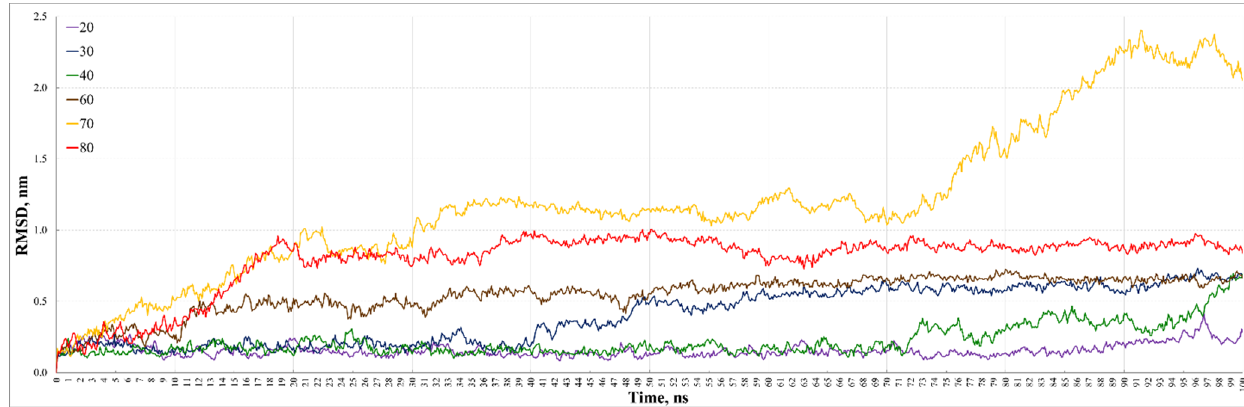
Figure 3. RMSD graphs of C α atoms of proteinase K dimers simulated in a solution at several temperatures (20, 30, 40, 60, 70, and 80 ◦